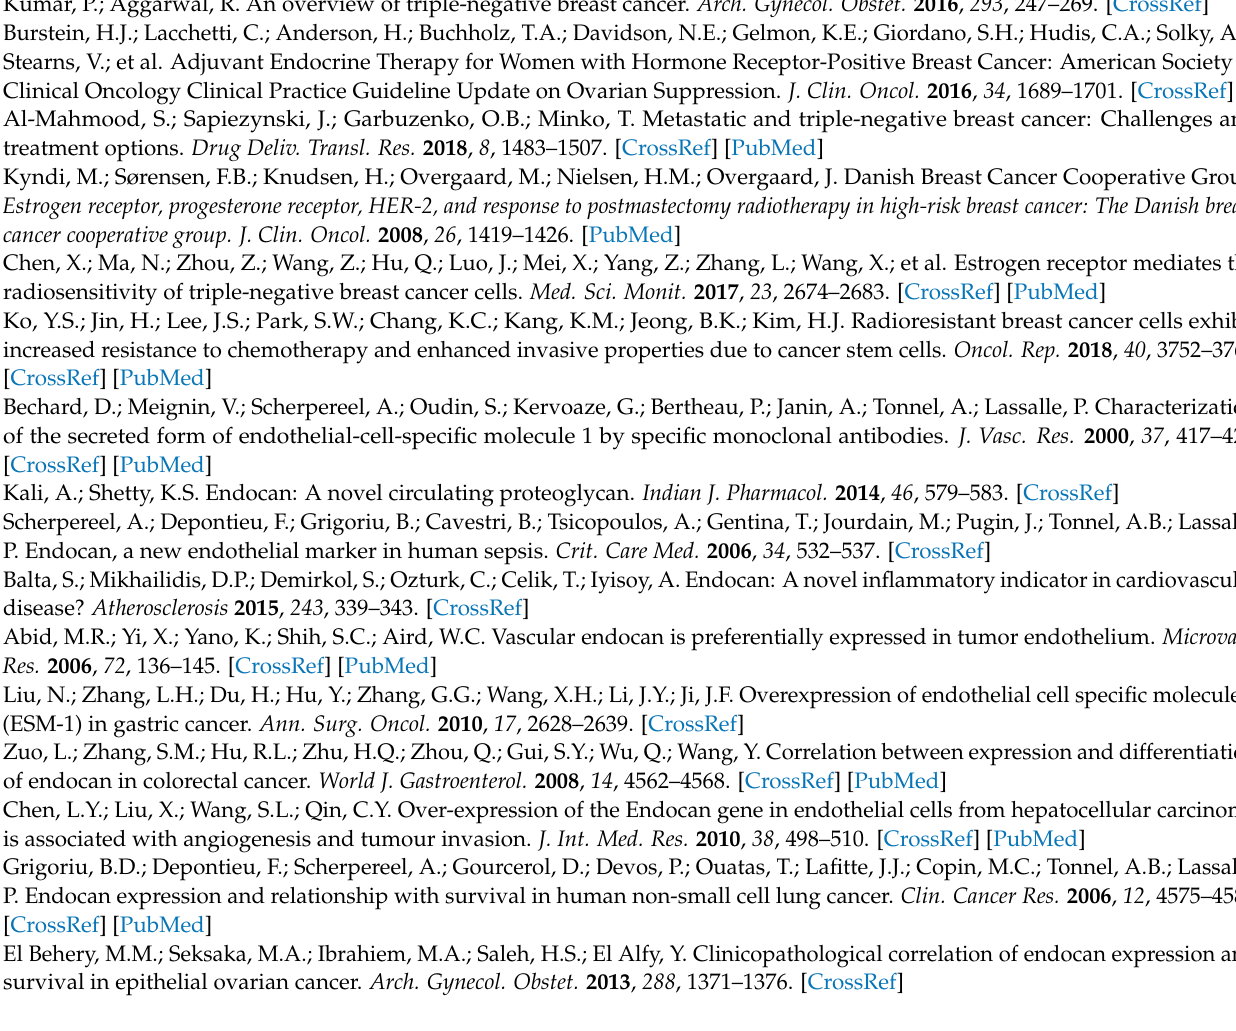
for Figure 1; Figure S2: The original Western blot images for Figure 2; Figure S3: The original Western blot images for Figure 3.; Figure S4: The original Western blot images for Figure 4; Figure S5: The original Western blot images for Figure 5; Figure S6: The original Western blot images for Figure 6; Figure S7: A2AR and A2BR siRNA did not affect ESM-1 expression levels; Figure S8: The original Western blot images for Figure